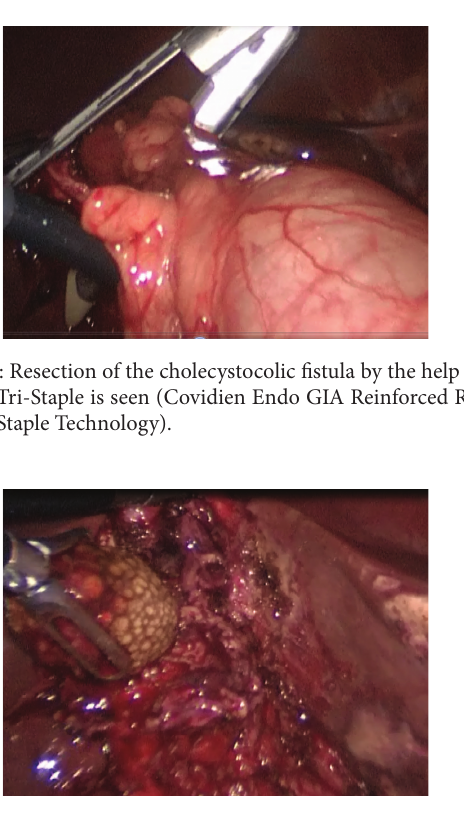
Figure 3: Extraction of large impacted stone from cholecystochole- dochal fistula trough opening of fundus is seen.